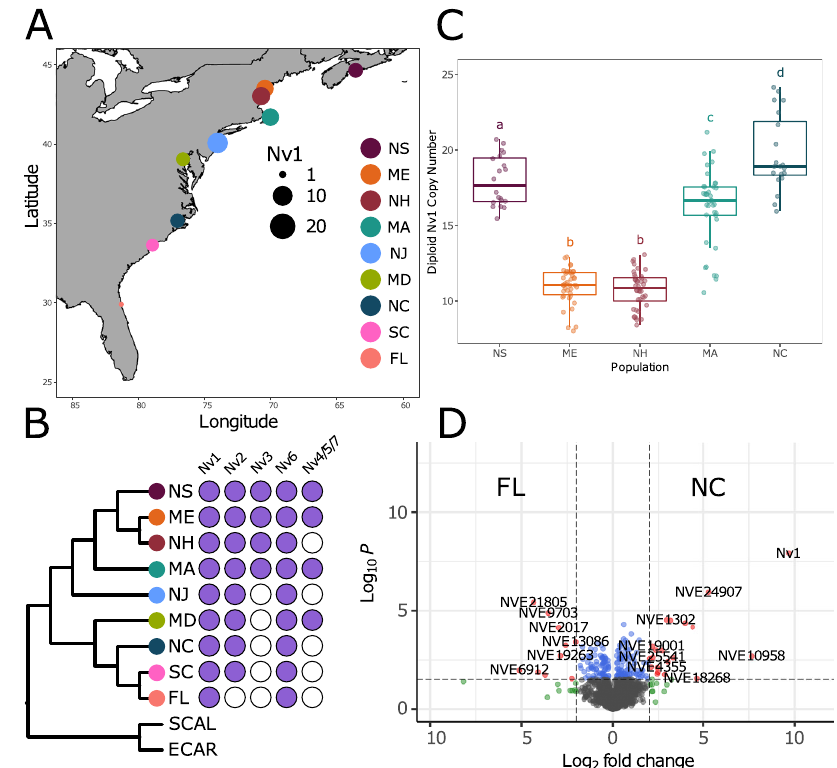
Fig. 4 | Diversity of NaTx paralogs among N. vectensis populations. A Map showing the location of the sampled populations across North America. Allele diversity represented by size of dot plot at different locations. Florida (FL), Mas- sachusetts(MA),Maryland(MD),Maine(ME),NorthCarolina(NC),NewHampshire (NH), New Jersey (NJ), Nova Scotia (NS), and South Carolina (SC). B Population structure of N. vectensis generated using a maximum-likelihood tree from protein sequences and presence/absence of previously characterized NaTx paralogs in N. vectensis . C Boxplots of diploid copy number estimated using qPCR from samples collected from the fi ve populations. The median is represented by the bold hor- izontallineandtheupperandlowerhingesrepresentthe75thand25thpercentiles, respectively.Theboxplotwhiskersextendtothe largestandsmallestvalueswithin 1.5*IQR (interquartile range) for the upper and lower whiskers, respectively. All